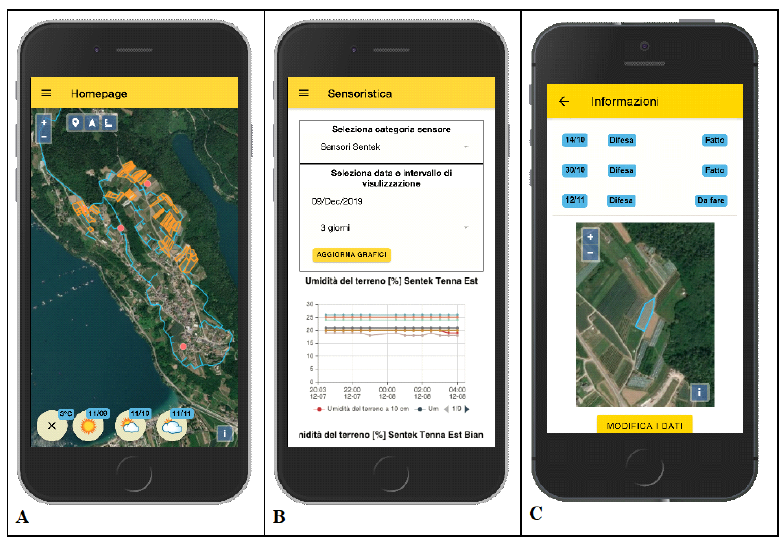
Figure 5. Progressive web application: ( A ) farm parcels and weather forecast, ( B ) moisture sensors data, and ( C ) agricultural activities register.